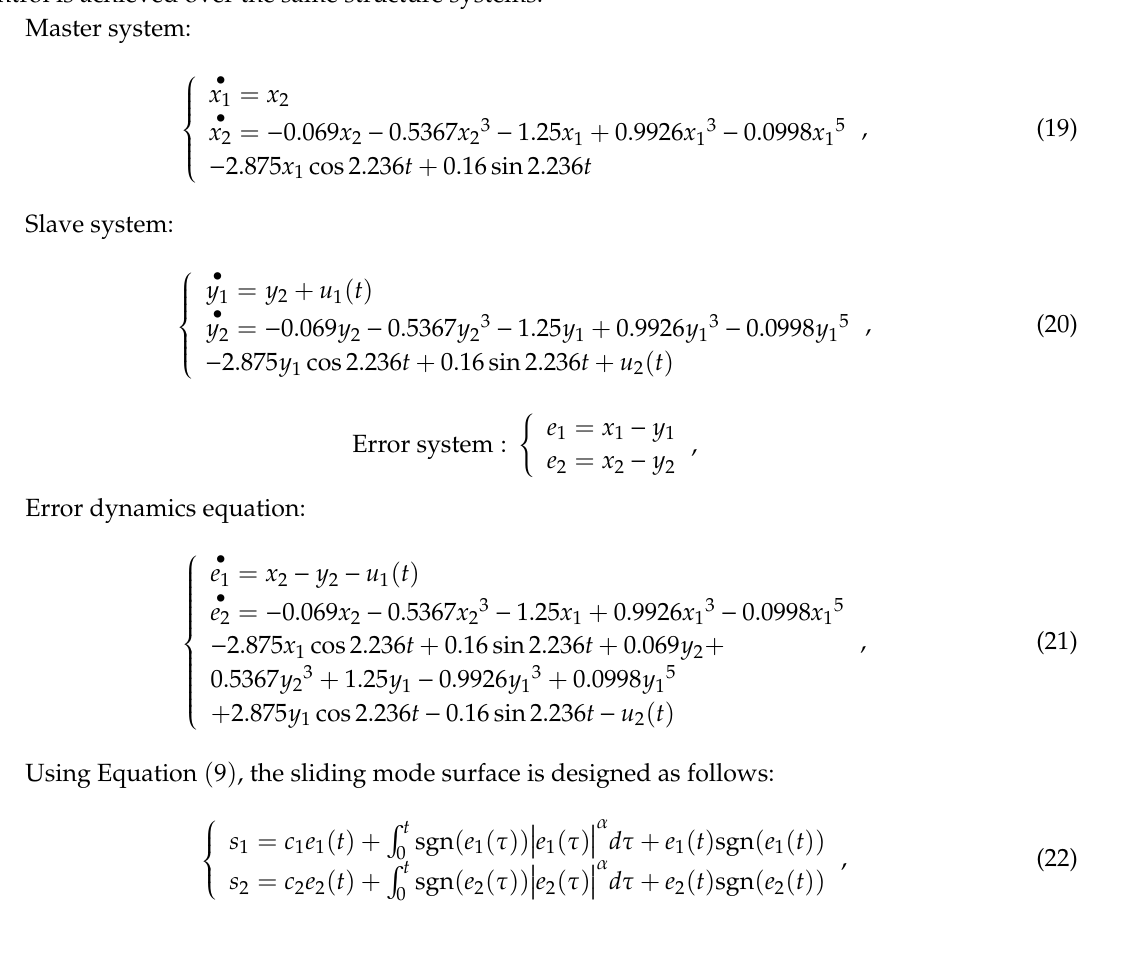
x x and 2 about ship parametric excitation rolling system.